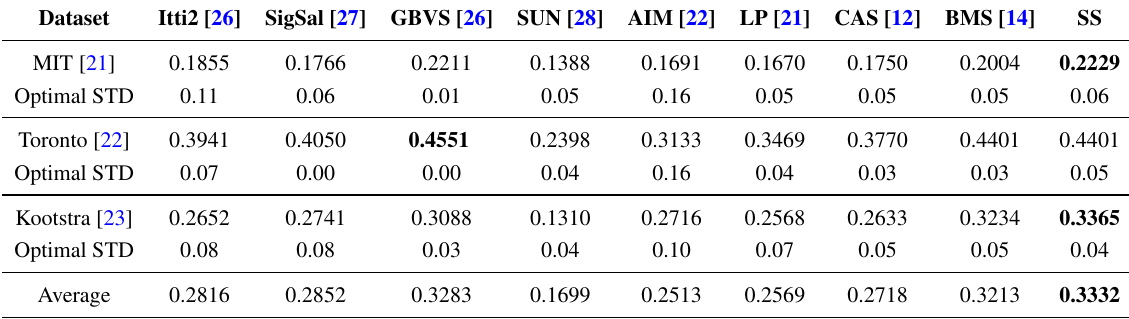
Table 3. Average CC score with optimal blurring. The highest score on each dataset is shown in bold. The second and third highest are